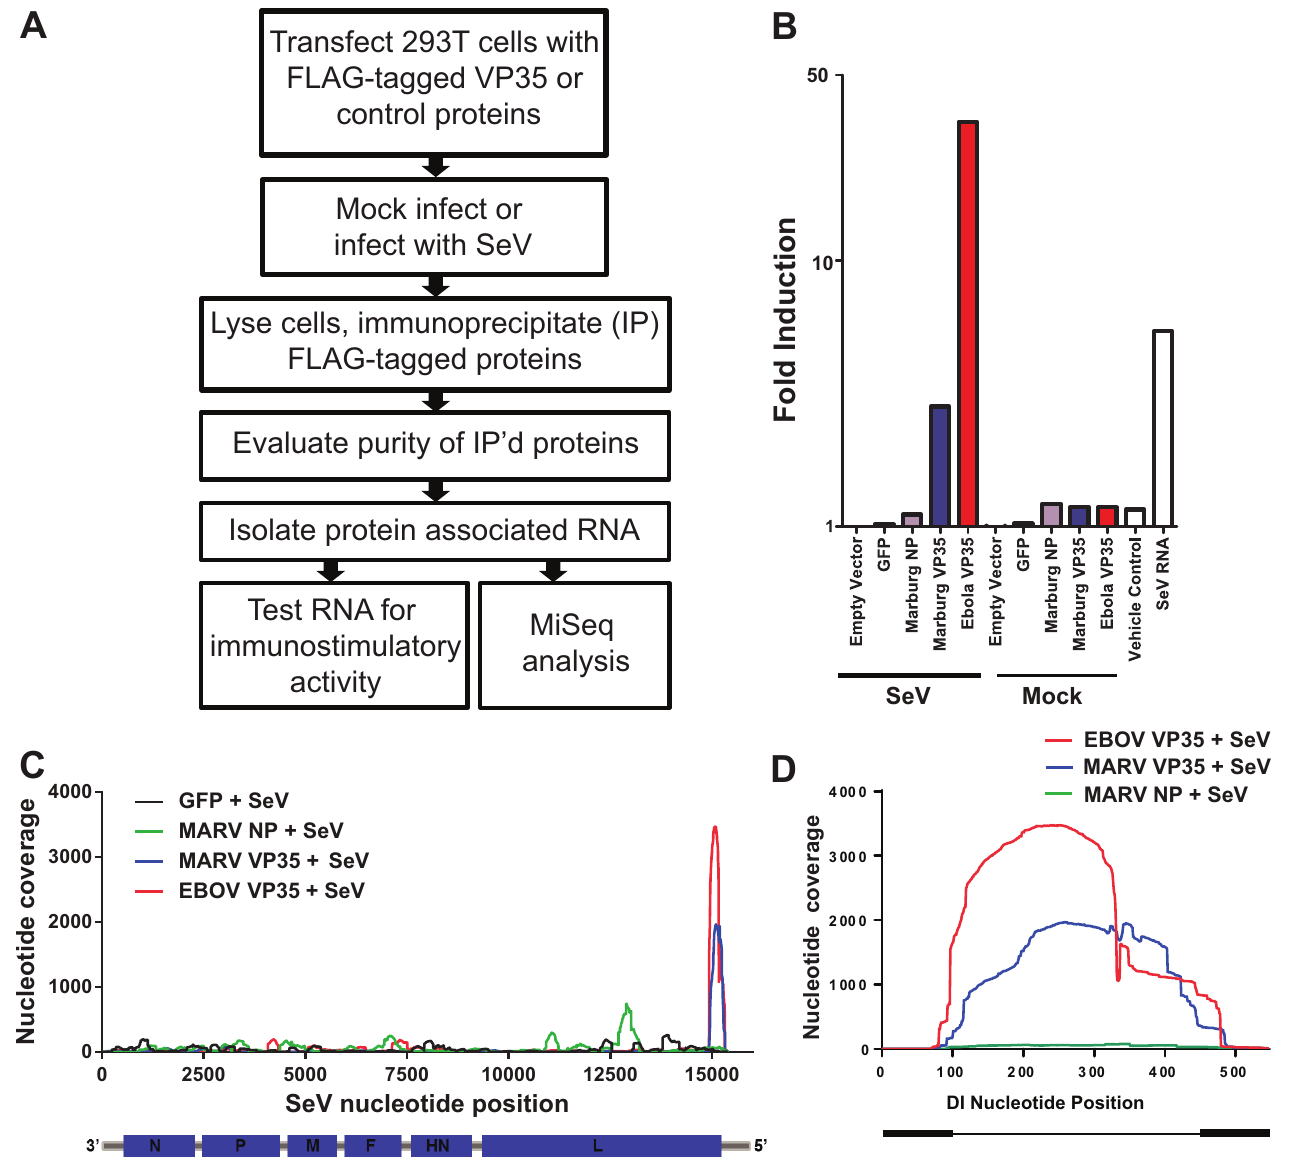
Fig 2. The type I IFN antagonist activity of VP35 correlates with its ability to bind the immunostimulatory Sendai virus defective interfering (DI) genome. (A) Overview of the methods used to characterize the RNA associatedwith VP35 in cells infected with SeV. (B) Immunostimulatory activity of RNA associatedwith FLAG-tagged filoviral proteinsin the presence(left, “SeV Infected”) or absence(right, “Mock Infected”) of SeV infection. Cells were transfected with a plasmid expressinga luciferase reporter under the control of the ISG54 promoter and then transfected with the isolatedRNA the followingday. “Vehiclecontrol” represents cells transfected with transfectionreagent alone. “SeV RNA” representscells transfected with viral RNA purifiedfrom the SeV stock. (C) Next-generation sequencingand mappingto the SeV genome.RNA associatedwith GFP, MARV NP protein, MARV VP35 protein, and EBOV VP35 was purifiedand subjectedto IlluminaSequencing. The graph depicts nucleotidecoverage(Y-axis) at each position of the SeV genome (X-axis). (D) Next-generation sequencing and mappingto the SeV DI genome.The same data from (C) was mappedto each nucleotide position of the SeV DI sequence.Thick black regions on each end of the DI diagram represent self-complementary sequencesthat presumably base-pair.